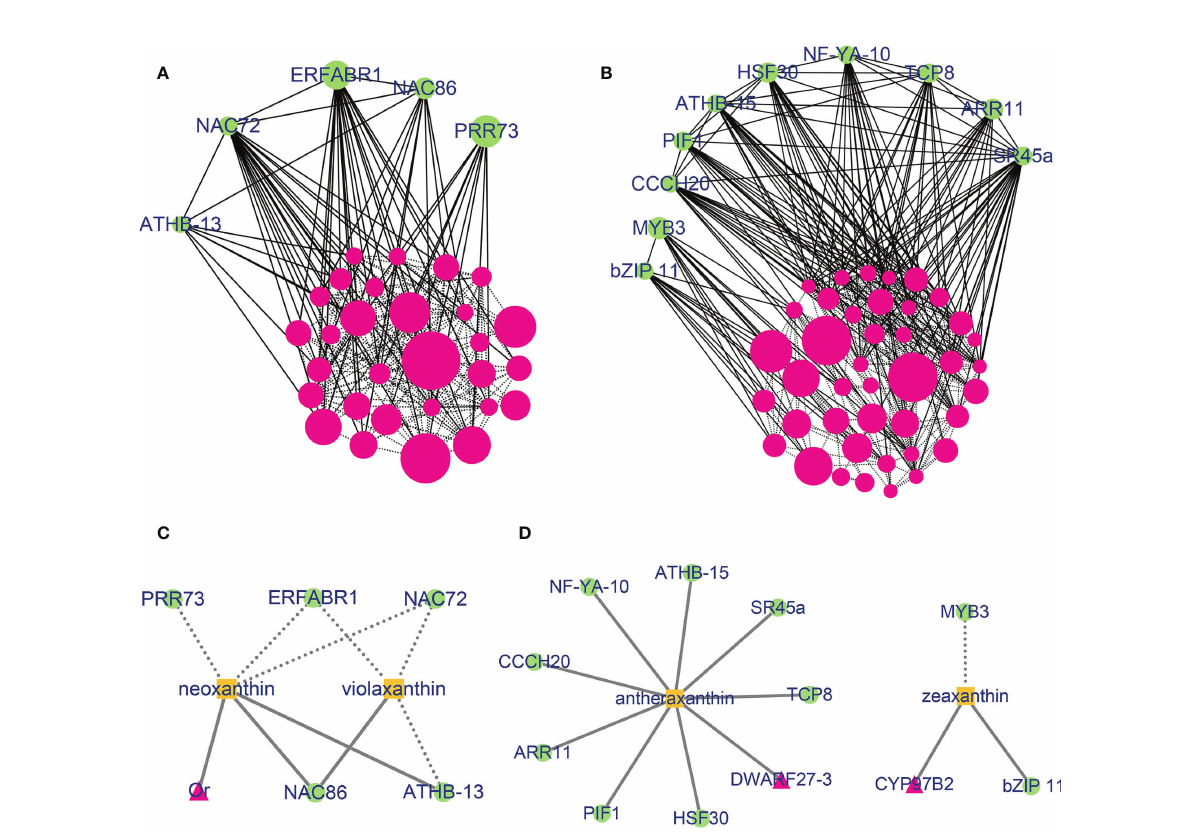
FIGURE 5 Co-expression network of genes in the blue and brown modules. (A) Gene co-expression network of the blue module. (B) Gene co-expression network of the brown module. The solid lines mean the interaction with transcription factors and dotted lines represent interaction between two genes. Dot sizes represent the weight between genes. Co-expression network of carotenoid metabolism genes and transcription factor in the blue (C) and brown (D) modules with carotenoids. The solid lines present that the genes were positively with carotenoids (GS > 0) and dotted lines represent that the genes were negatively with carotenoids (GS< 0). Rose red, proteins; Green, transcription factors; Orange,